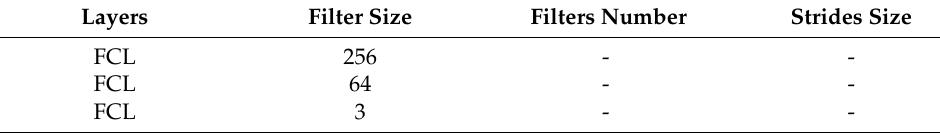
Table 11. DICNN configuration of dense